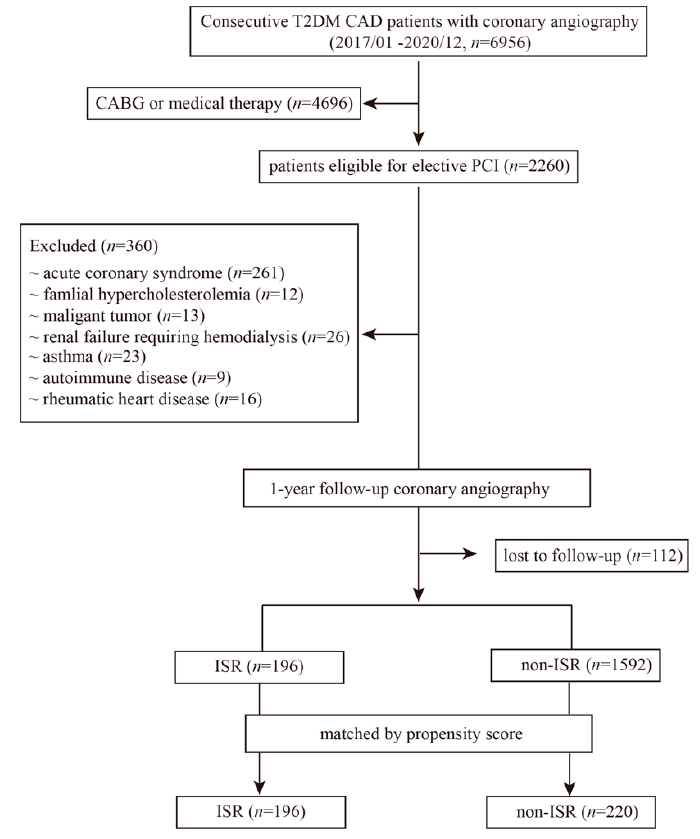
Figure 1. Flow chart of recruitment procedure. T2DM: type 2 diabetes mellitus; CAD: coronary artery disease; PCI: percutaneous coronary intervention; CABG: coronary artery bypass grafting; ISR: in-stent restenosis.